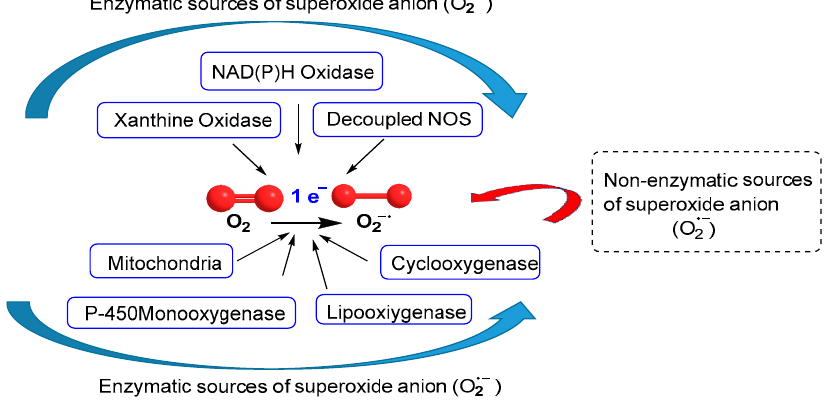
Figure 8. Enzymatic sources of superoxide anion and non-enzymatic production of superoxide [25].